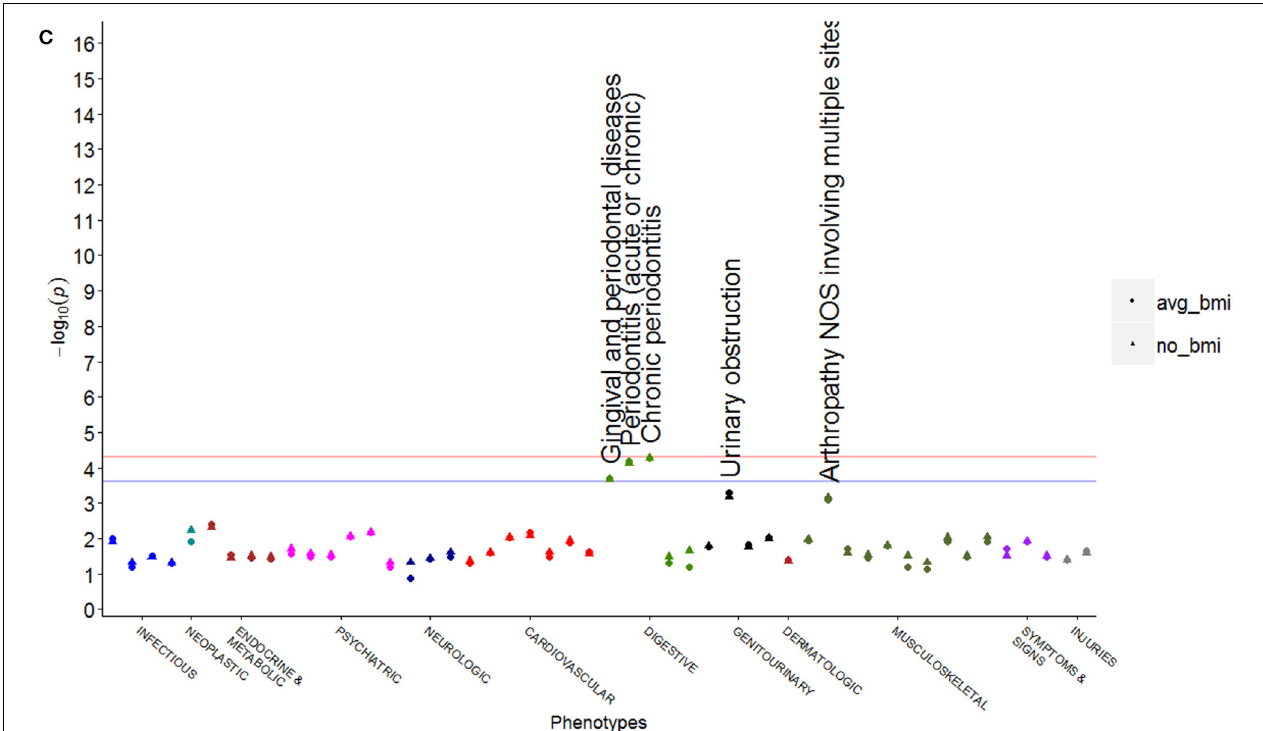
obesity or diabetes does show significant association with non-inflammatory disorders of the cervix ( OR = 6 . 76, p = 1 . 92 × 10 − 6 ), unaffected by adjustment for BMI ( OR = 6 . 66, p = 2 . 36 × 10 − 6 ) (C) rs7199182 is only present in the eMERGE population and has a low LD with rs8050136 ( r 2 = 0 . 04) and is associated with chronic periodontitis before and after BMI adjustment (no adjustment: p = 5 . 40 × 10 − 5 ; BMI adjustment: p = 5 . 20 × 10 − 5